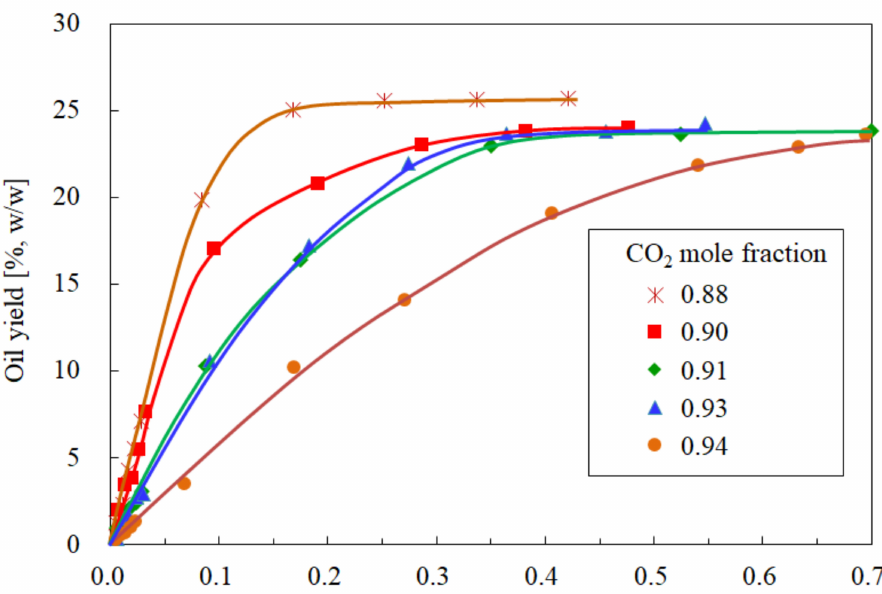
Figure 3. Plot of the oil yield of rice bran vs. the amount of CO 2 -expanded hexane solvent with various CO 2 mole fractions at 25 ◦ C and 5.1–5.2